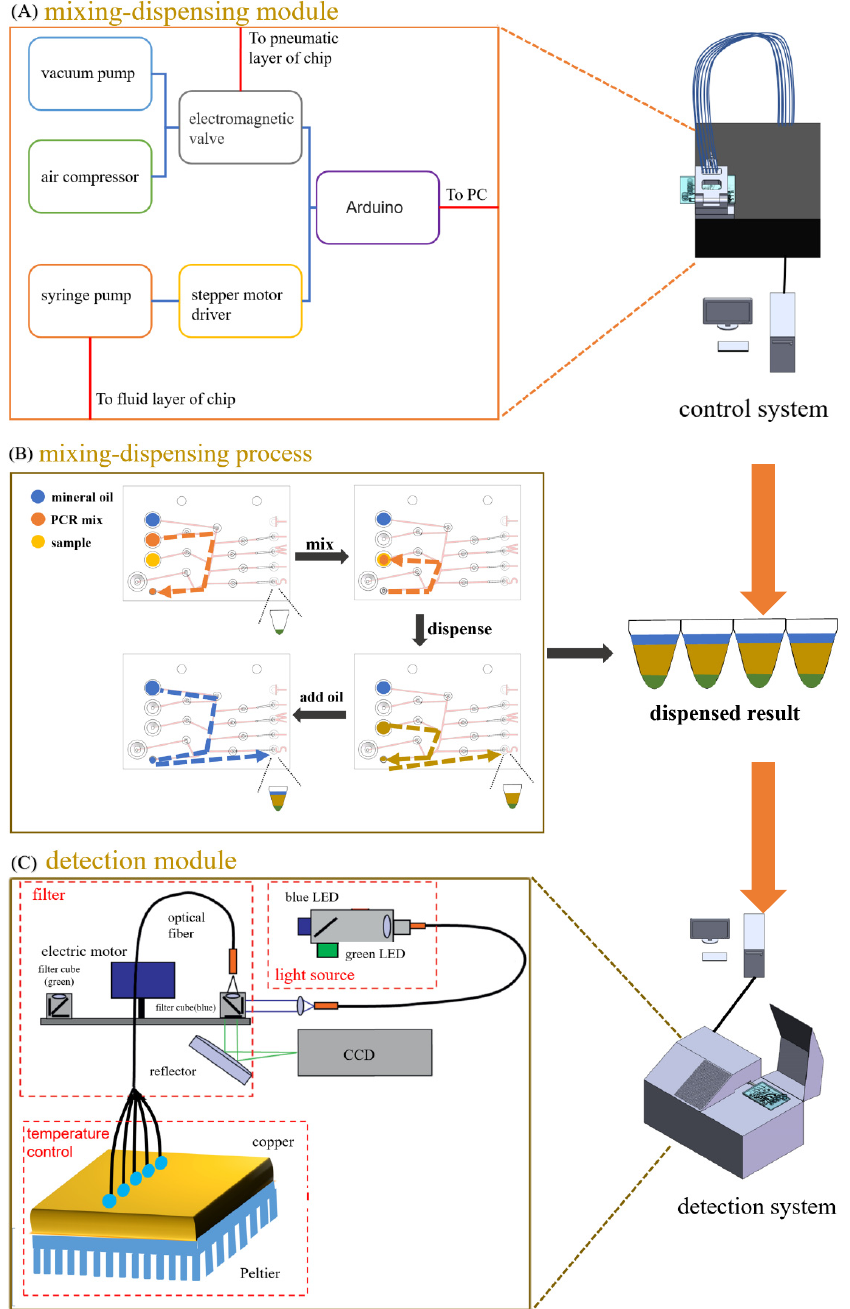
Figure 2. ( A ) Structure diagram of the mixing-dispensing module. ( B ) Schematic illustration of mixing and dispensing process. ( C ) Structure diagram of the detection module.